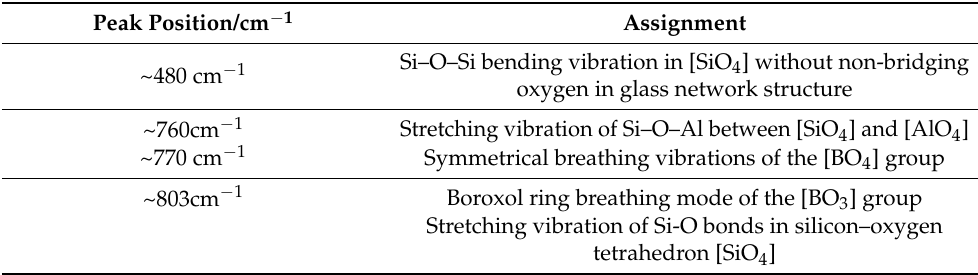
Figure 4. Raman spectra of Li 2 O − Al 2 O 3 − SiO 2 system glass with different B 2 O 3 contents. Table 5. Raman vibration groups of